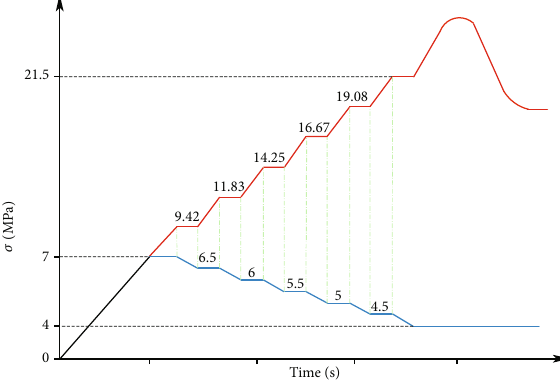
Figure 3: Alternate loading and unloading Table 2: Testing program of variable loading and unloading rates under alternate loading and unloading paths.